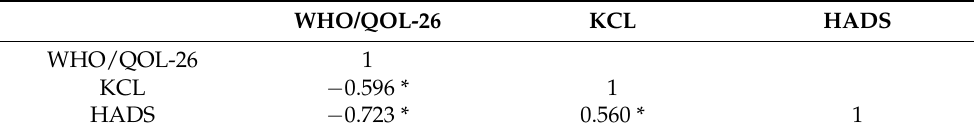
Table 2. Correlations among scores of WHO/QOL-26, KCL and HADS.